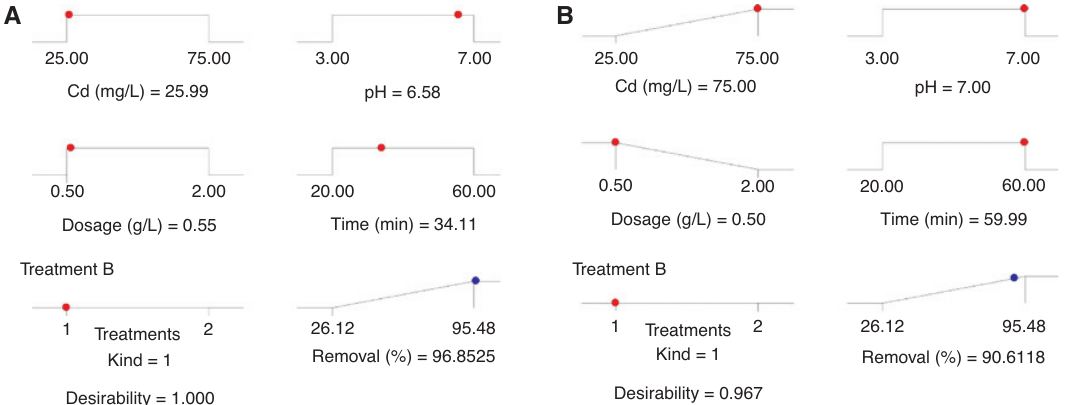
Figure 10: Desirability ramp for the optimization of the response and the variables (A, first test; B, second test).